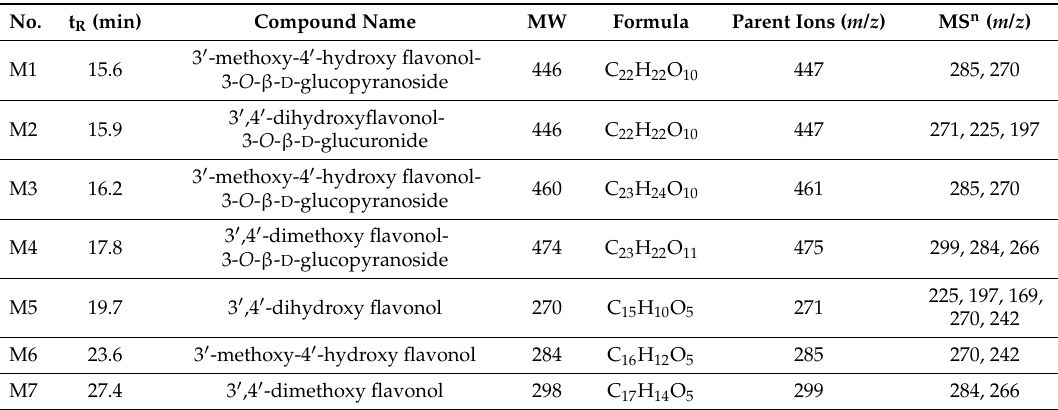
Table 1. Mass spectrometry (MS n ) data of metabolites of DF3G.